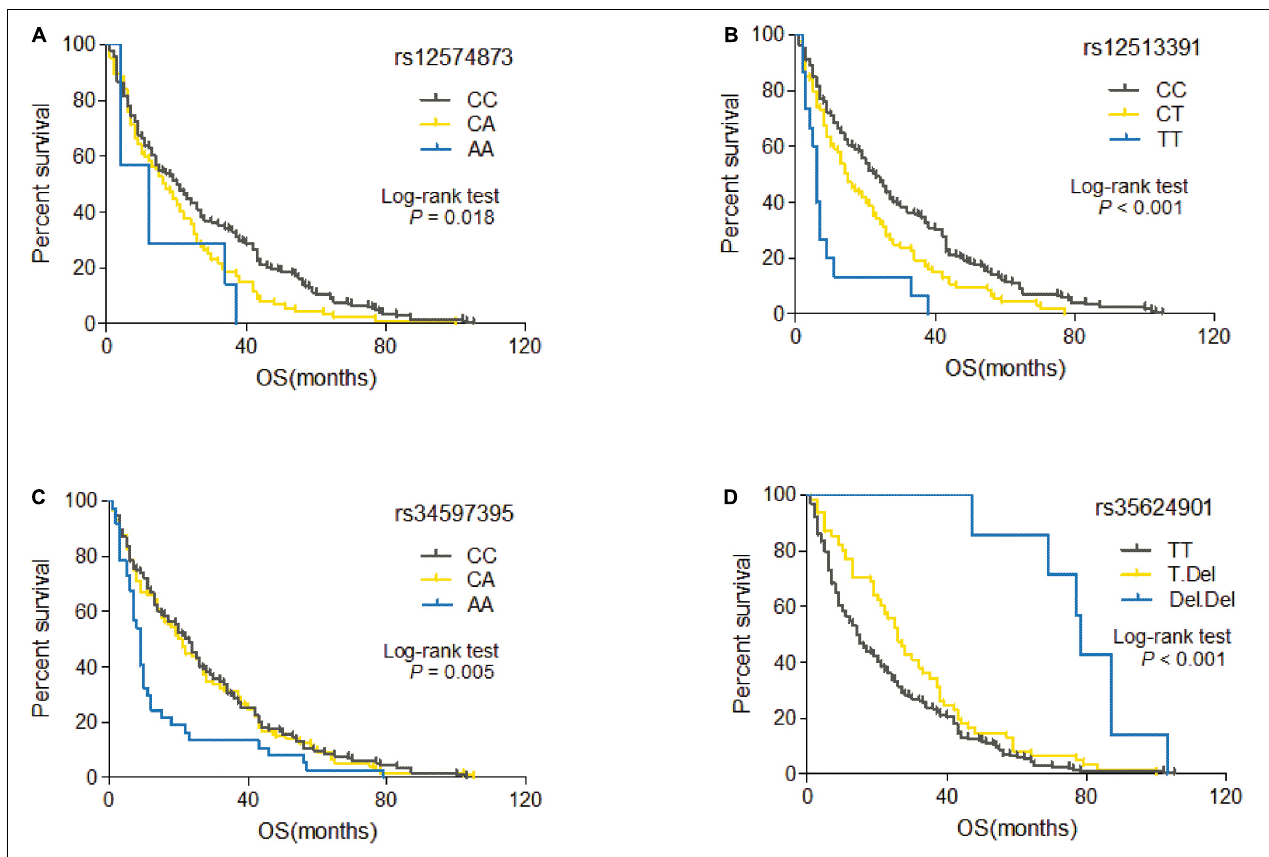
FIGURE 2 | Kaplan–Meier curve of OS for TACE-treated HCC patients with different genotypes of rs12574873 (A) , rs12513391 (B) , rs34597395 (C) , or rs35624901 (D)